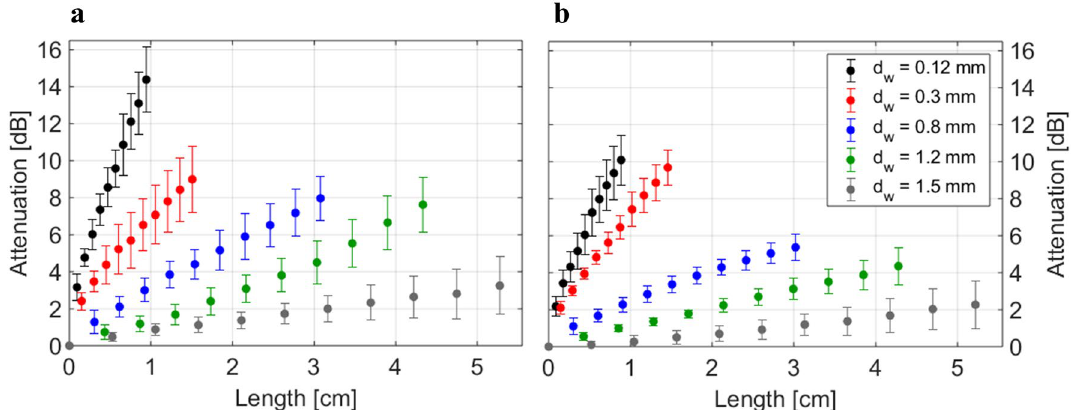
Figure 1. Attenuation D of POFs 1143 ( a ) and 1144 ( b ) as a function of fibre length for different diameters of the bending cylinder d w . Data are shown as mean ± standard deviation ( n =